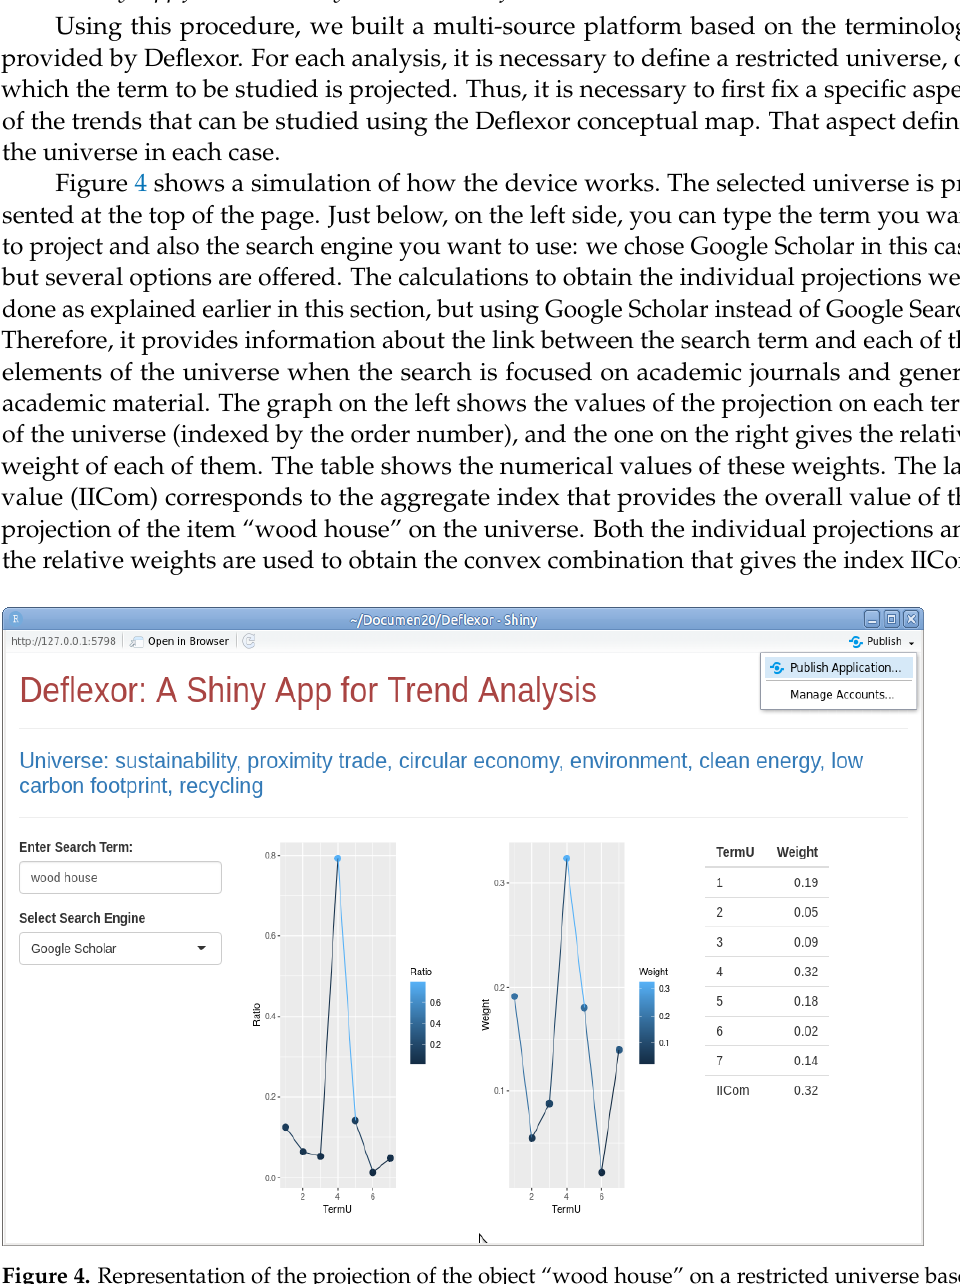
Figure 4. Representation of the projection of the object “wood house” on a restricted universe based on